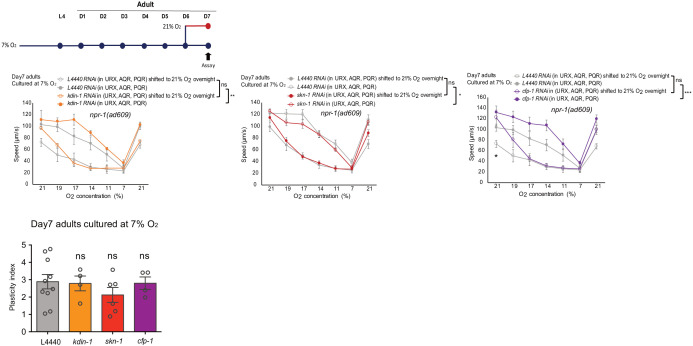
O2-evoked speed responses and plasticity index of 7% O2 cultured day 7 adults.Mean ±sem, *p<0.05, **p<0.01, ***p<0.001, ns, p>0.05, asterisks above the speed plot indicate a significant interaction between the effect of gene knockdown and [O2] steps on speed responses, asterisks next to the data point in the plot indicate a significant difference of speed at this [O2] point compared to either RNAi feeding or control animals experienced the same O2 culture condition.